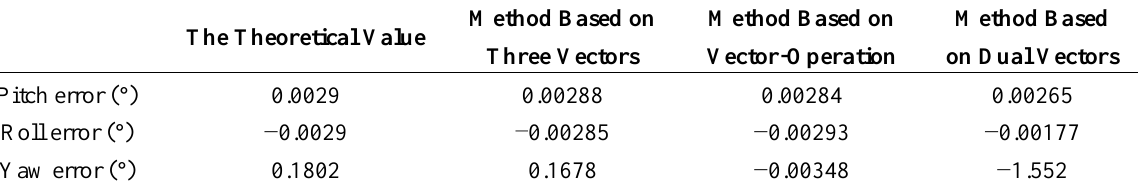
Figure 11. Alignment errors in case 1. Table 7. The alignment errors in case 1.